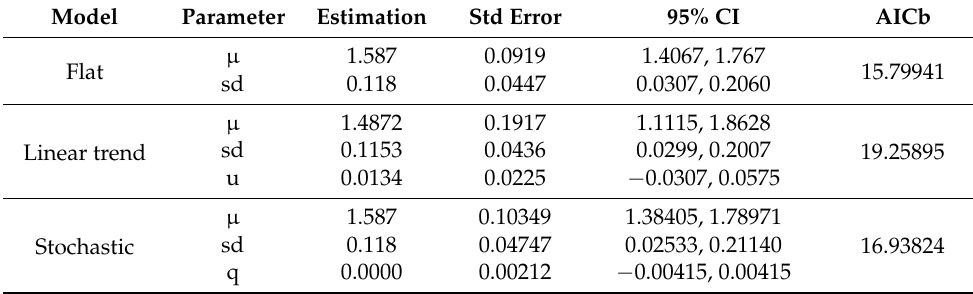
Table 4. Comparison of the three models for the juvenile to adult ratio